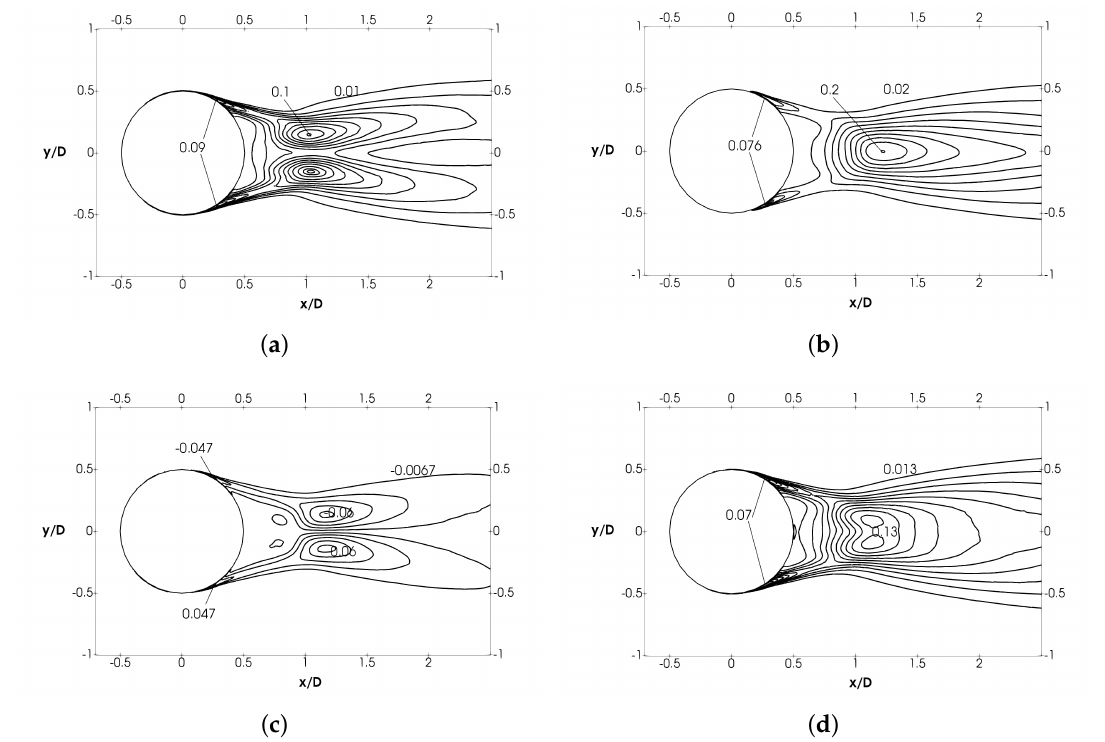
(cid:105) / U 2 u (cid:48) , ( b ) cross-stream wise normal ref 1 1 ref